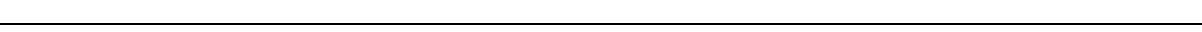
depleted in knockout cells. Both STING − / − and UBXN3B − / − cells were more permissive to HSV-1 infection than WT (Fig. 2i); the